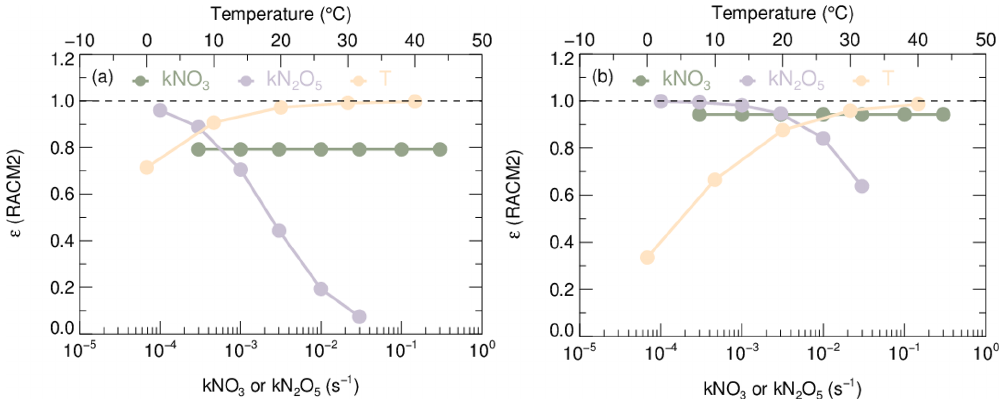
Figure 2. Sensitivity plot of kNO 3 , kN 2 O 5 , and temperature ( T ) against coefficient ε . The trace of T is plotted against the upper horizontal axis, and the traces of the other two parameters are plotted against the lower horizontal axis. (a) The basic model condition is according to typical winter conditions of PKU2017. (b) The basic model condition is according to typical summer conditions of TZ2018. Basic model conditions including kNO 3 , kN 2 O 5 , and temperature ( T ) are shown in Table S2. It should be noted that the provided ranges of each factor do not exactly equal but encompass the ambient conditions encountered during the two campaigns.